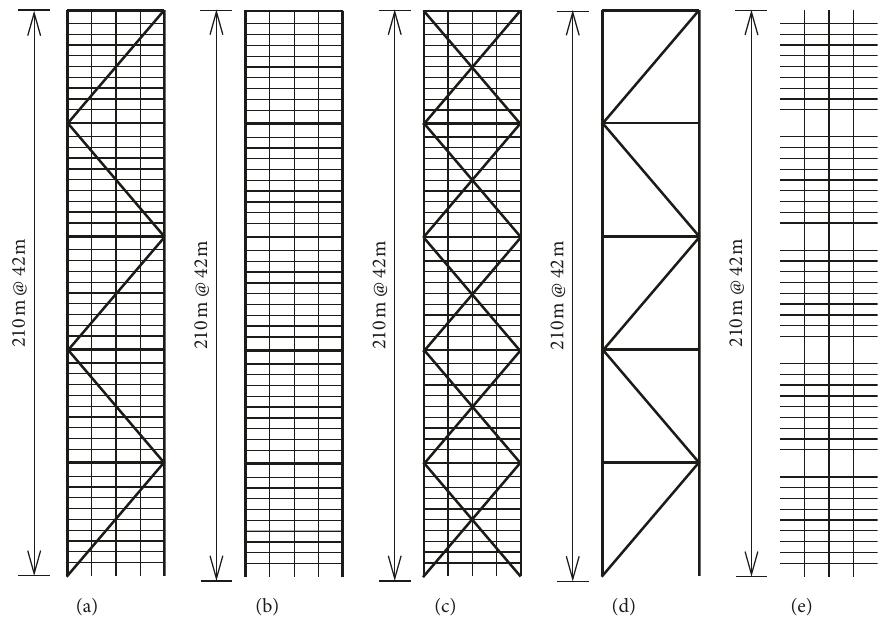
Figure 2: Elevation of 50-story primary frame- and secondary frame-braced structure analysis models: (a) 5MBC; (b) 5MC; (c) 5MXBC; (d) primary frame of 5MBC; (e) secondary frame of 5MBC.